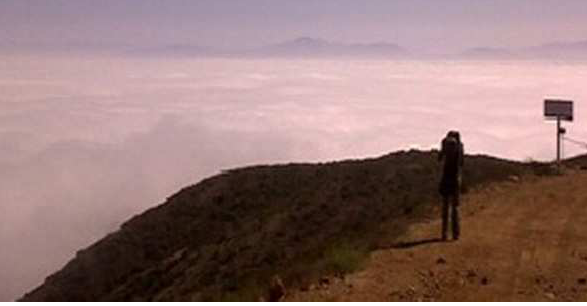
Fig. 10. Natural and scenic resources.